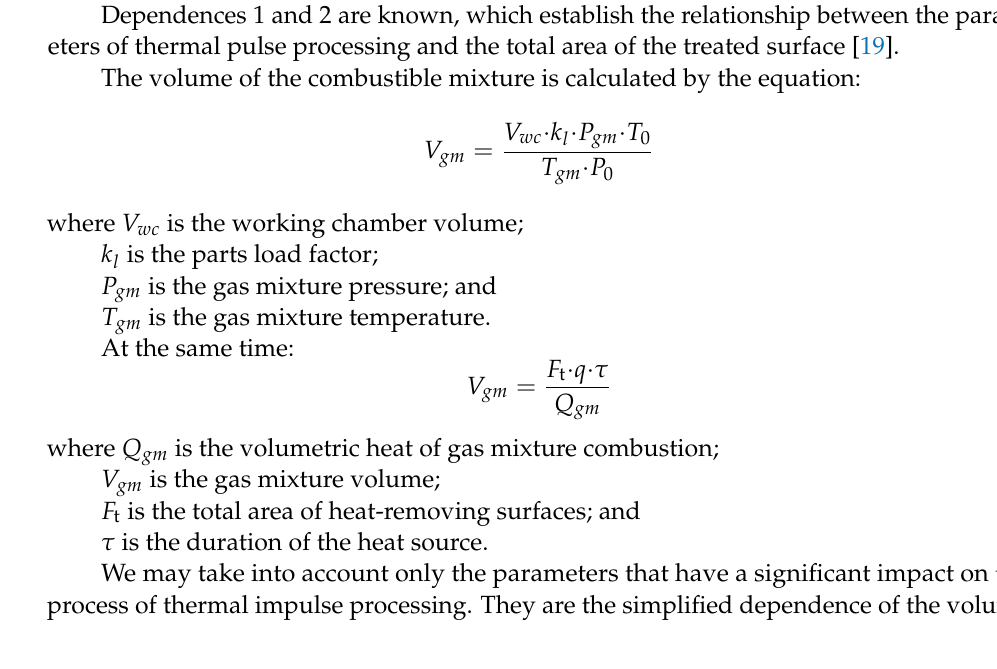
Figure 8. Thread surface quality after thermal pulse processing in the rational mode of P = 1760 kPa.